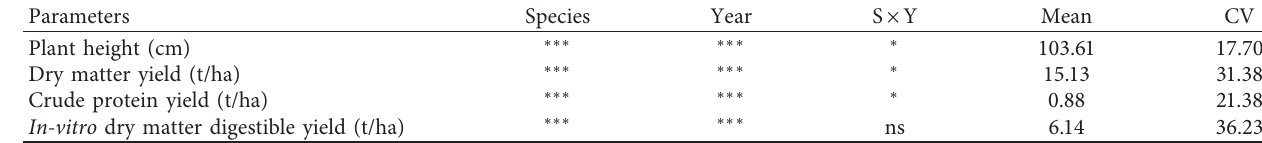
Table 3: Species and year effect on the plant, dry matter, and crude protein yield of perennial grass evaluated under irrigation. Parameters